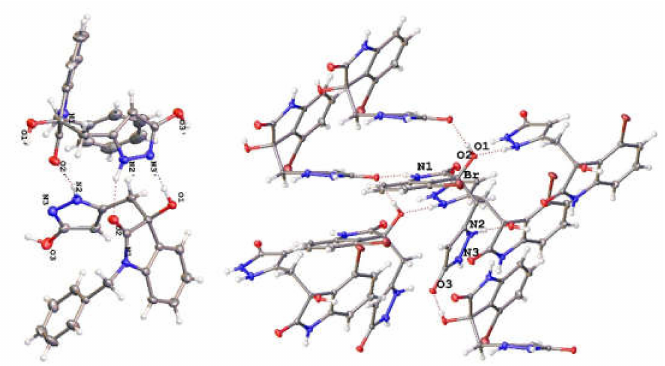
Figure 5. Pictures showing the packaging in the crystal structure of 15l (left side) and 15c (right side). The H-bonding interactions between the molecules can be noticed (N2 / N3 = N15 /